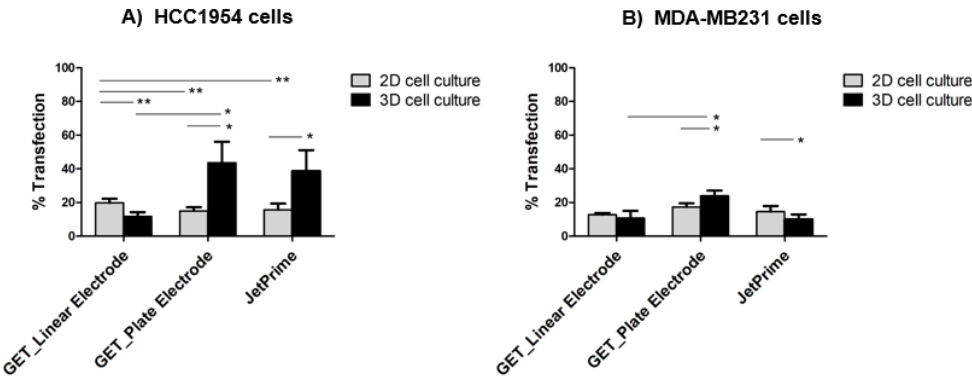
Figure 4. Percentage of cell transfection of HCC1954 ( A ) and MDA-MB231 ( B ) cell lines in 2D and 3D cultures measured three days after EP (with linear or plate electrode) or JetPrime ® . Data are from three replicates per experimental condition, in two independent blind experiments (Mean SD).